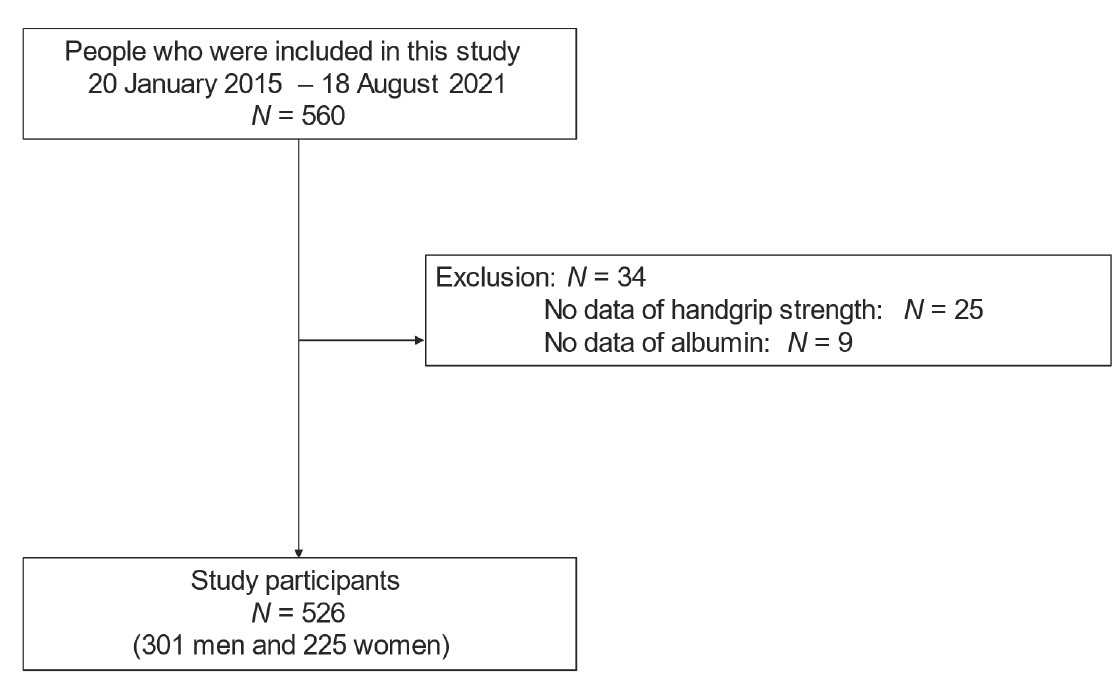
Figure 1. Study flow diagram of the people registration process. The clinical characteristics of the study participants are summarized in Table 1. The mean age or BMI was 67.1 ± 10.9 years or 24.4 ± 4.3 kg/m 2 in all participants. The mean BMI was 23.9 ± 3.6 kg/m 2 in men and 25.0 ± 5.0 kg/m 2 in women. The proportions of par-